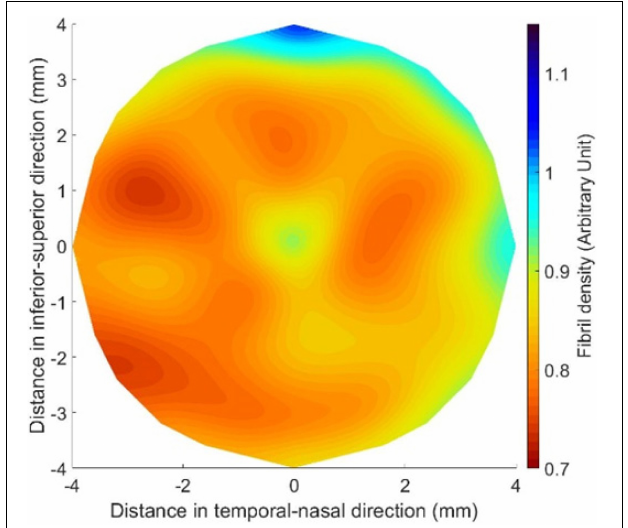
FIGURE 1 | Mean fibril density in the central 8.0-mm-diameter area of healthy corneas after being fitted to Zernike polynomials of the 10th